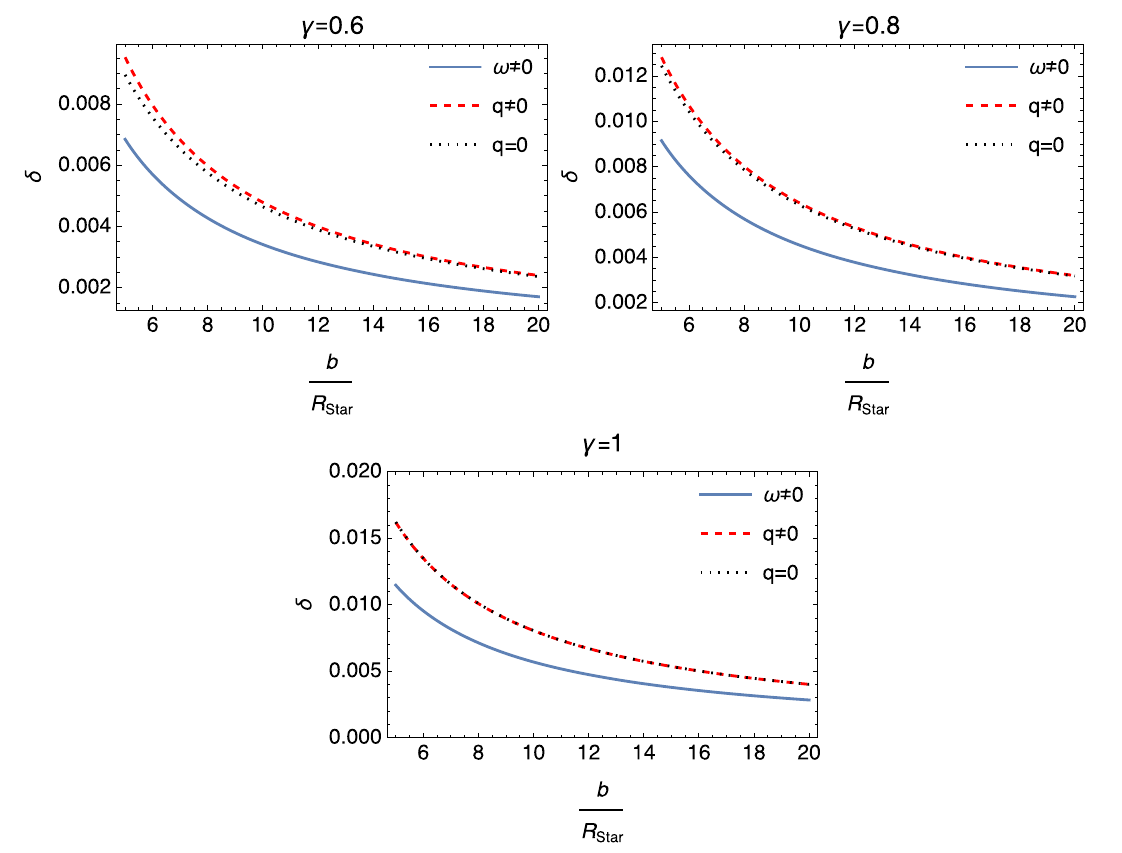
uncharged ( q = 0 ) . Note that bending angle for stationary state is less than the static cases for each particular γ